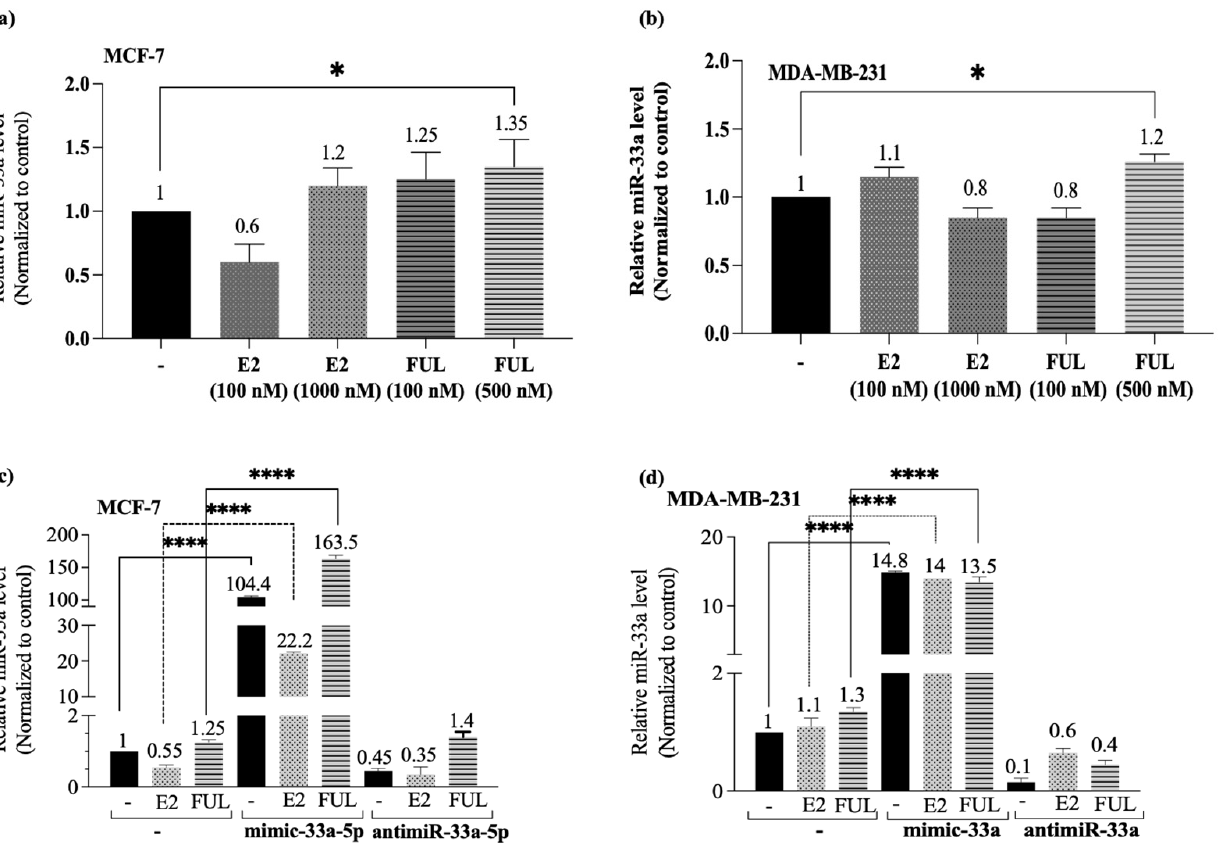
Figure 2. The expression profile of miR-33a, which was modulated by mimic and anti-miR transfections, in 17- β -Estradiol (E2) or Fulvestrant (FUL) treated MCF-7 and MDA-MB-231 cells. The relative miR-33a expression in 17- β -Estradiol (E2) and Fulvestrant (FUL) treated MCF-7 ( a ) and MDA-MB-231 ( b ) cells were detected by the qRT-PCR assay. Columns represent the mean ± Std.dev of three independent experiments with two repeats (* p = 0.0491 in MCF-7 cells, * p = 0.0381 in MDA-MB-231, by one-way ANOVA, Dunnett’s multiple comparison test). The mimic and anti-miR transfections changed the expression of miR-33a in MCF-7 cells ( c ) and in MDA-MB-231 cells ( d ). Columns represent the mean ± Std.dev of three independent experiments with two repeats (**** p < 0.0001 by two-way ANOVA, Tukey’s multiple comparison test). Treatment of cells with mimic-33a increased its expression in MDA-MB-231 cells in the presence of both E2 and FUL. We suggested that due to the ER α − /ER β + characteristics of MDA-MB-231 cells, E2 or FUL treatment did not affect the miR-33a level directly.